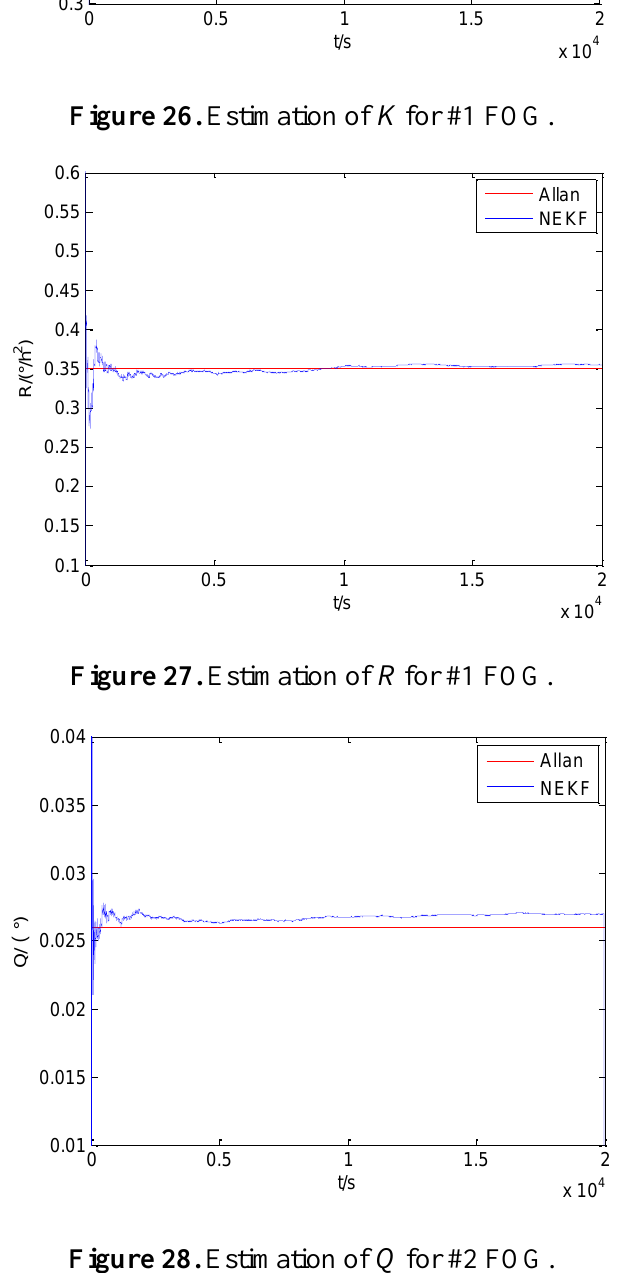
Figure 28. Estimation of Q for #2